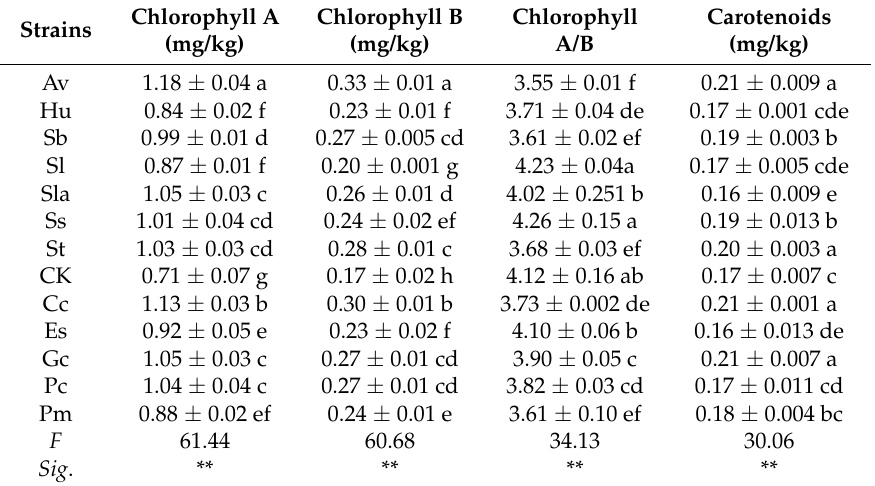
Table 3. ANOVA analysis of pigment parameters of the seedling needles of different ECMF and DSE inoculation